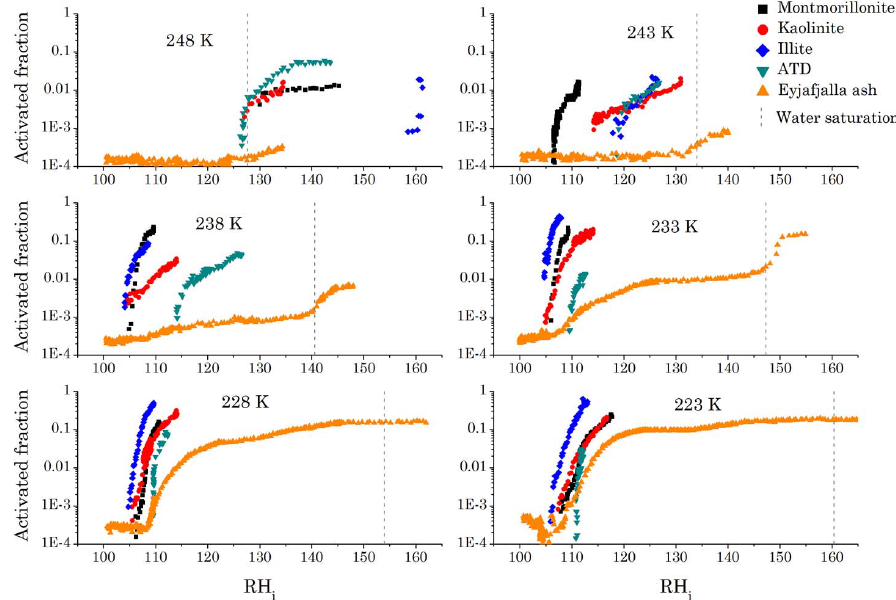
Fig. 7. The fraction of activated (ice coated) ash particles (from the Ey0 ash sample) for deposition mode experiments, as a function of the relative humidity with respect to ice, for different temperatures (orange triangles). Also plotted for comparison: deposition freezing measurements for 800nm size-selected mineral dust particles (Welti et al., 2009). The vertical grey line represents water